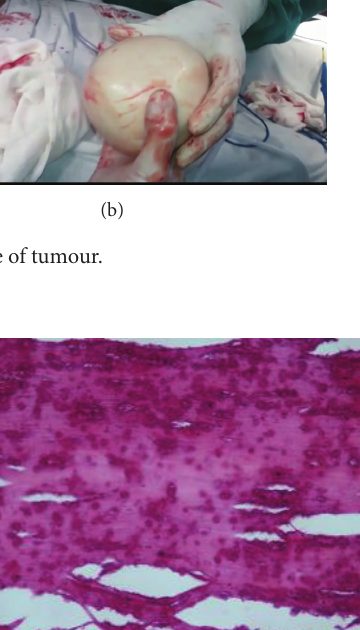
Figure 3: Cut open specimen of tumour.